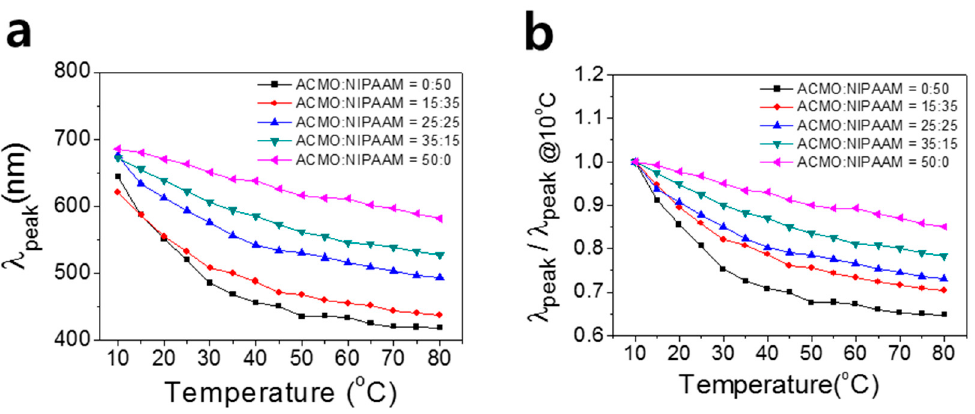
Figure 6. ( a ) Plot of the stopband positions ( λ peak ) of five different IO photonic gels vs. temperature; ◦ C with temperature ranges of 10–80 ◦ ( b ) Plot of λ peak normalized to that of 10 °C with temperature ranges of 10–80 °C. ( b ) Plot of λ peak normalized to that of 10